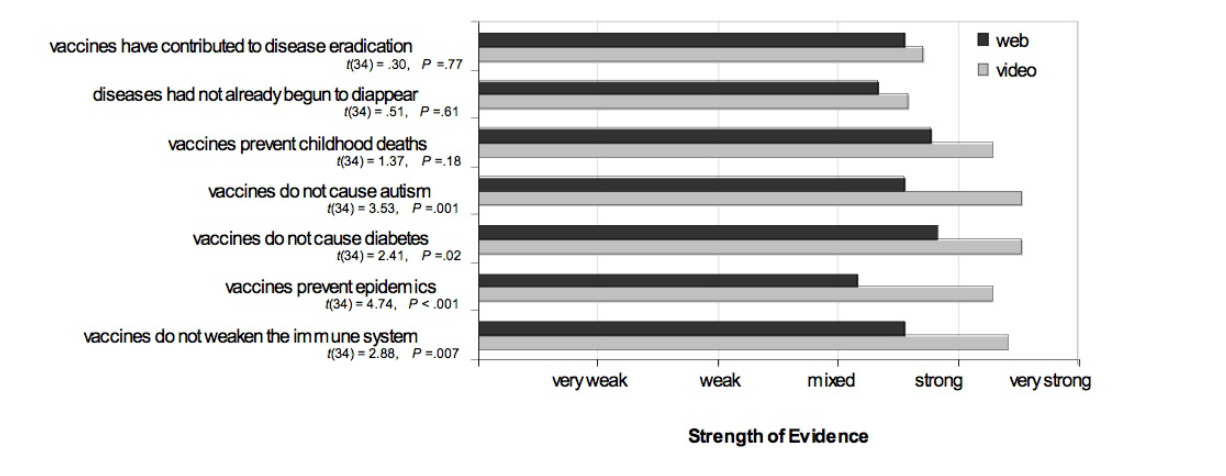
Figure 3. Average response to questions about the strength of evidence for statements about vaccines (dark bars are scores collected after the Web search exercise; light bars are scores collected from the same participants following the video